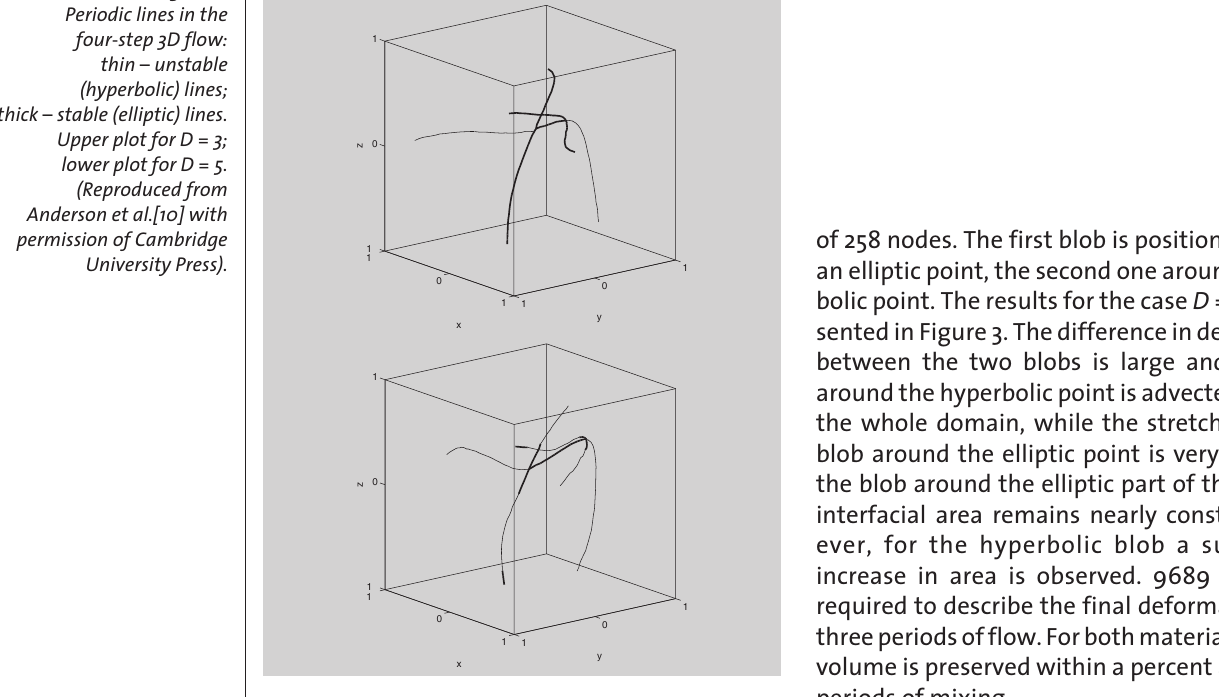
Figure 2: Periodic lines in the four-step 3D flow: thin – unstable (hyperbolic) lines; thick – stable (elliptic) lines. Upper plot for D = 3; lower plot for D = 5. (Reproduced from Anderson et al.[10] with permission of Cambridge University Press).